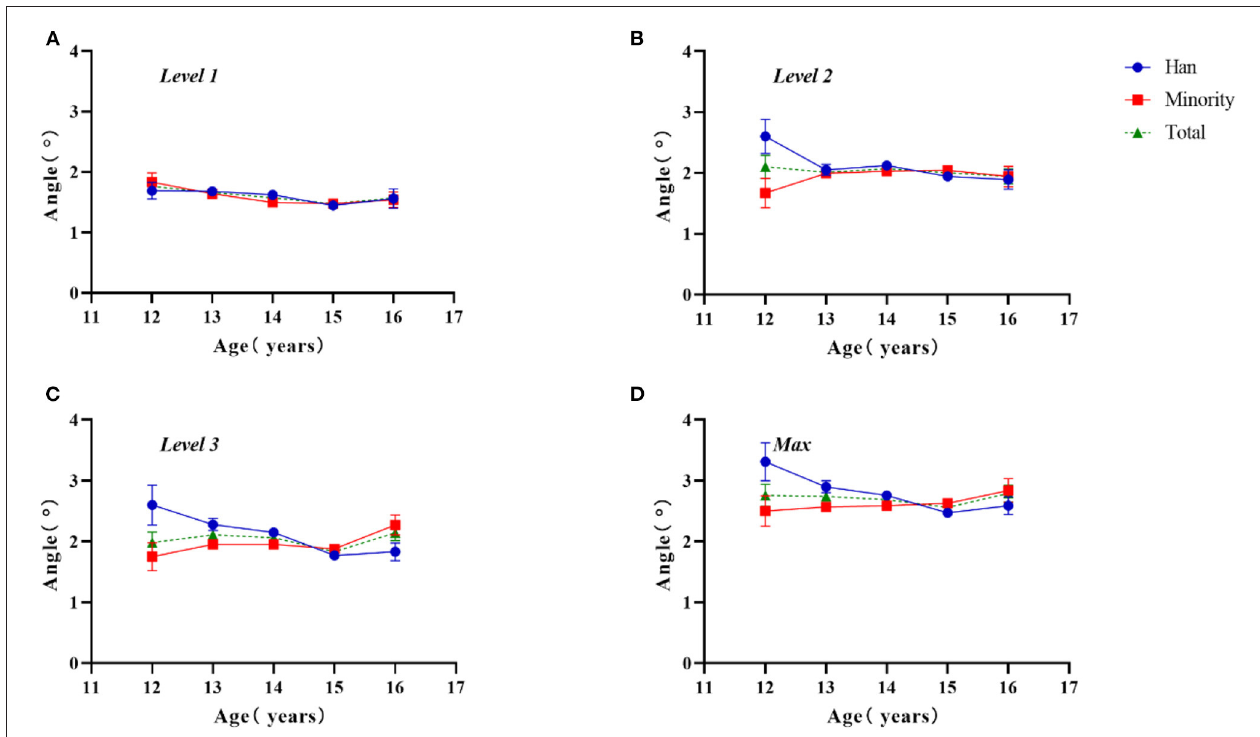
FIGURE 1 | Two-factor analysis of variance to assess differences in ATR values by ethnicity and age. (A) Level 1, proximal thoracic (T1–T4); (B) level 2, main thoracic (T5–T12); (C) level 3, lumbar (T12–L4); (D) Max, maximum value among the three